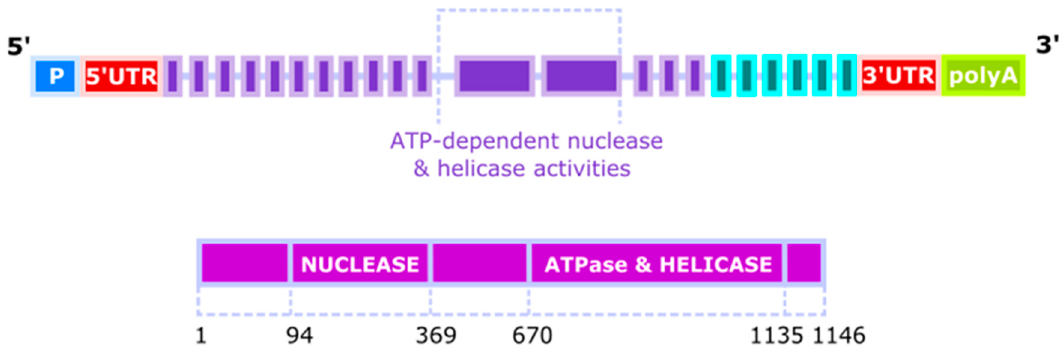
Figure 1. The structure of the human DNA2 (DNA replication helicase/nuclease 2) gene and protein. The DNA2 gene has three probable alternative promoters (P), 5 ′ and 3 ′ untranslated regions (UTR) and 4 validated alternative polyadenylation sites (polyA). An approximation position of the elements of the DNA2 gene and the DNA2 protein in aa is shown.